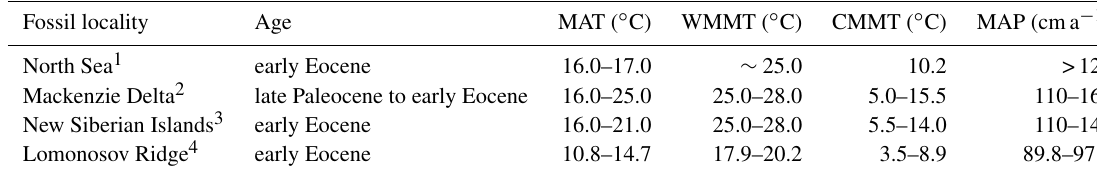
Table 3. Compiled Arctic temperature proxy data from additional early Eocene sources.